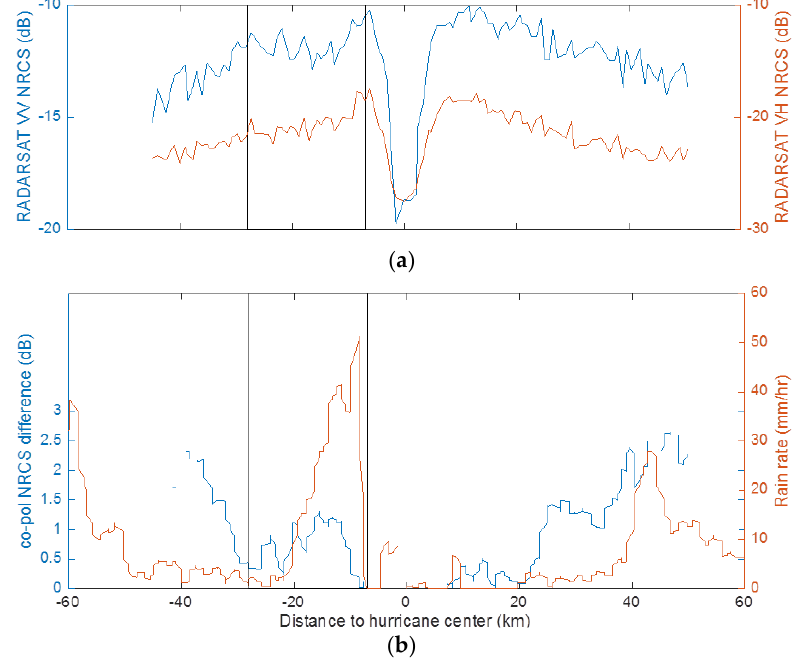
Figure 5. NRCS of ( a ) SAR co-pol, and ( b ) difference between SAR and simulated co-pol profiles, overlaid with the rain rate along the airborne track of the NOAA43 SFMR measurement. The area in the box corresponds to heavy rainfall in the eyewall. The lower panel also shows rain-induced co-pol NRCS changes as recognized by SAR observations and model simulations.